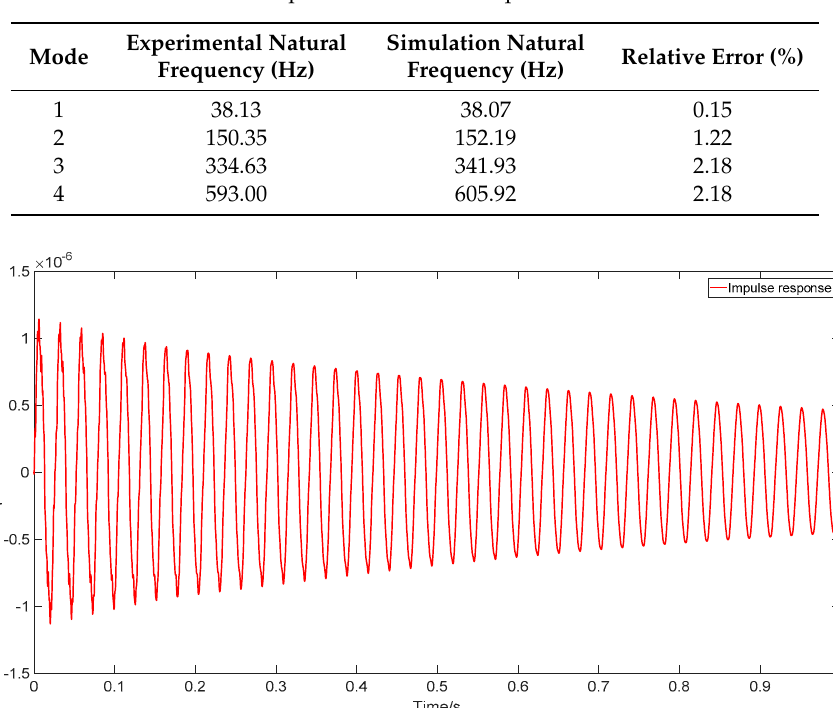
Table 6. The comparison of natural frequencies of the beam.